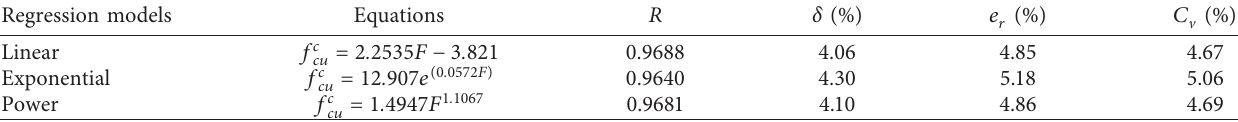
Table 10: Various regression models used to estimate the compressive strength of PFRC from postinstalled pull-out forces. Regression models